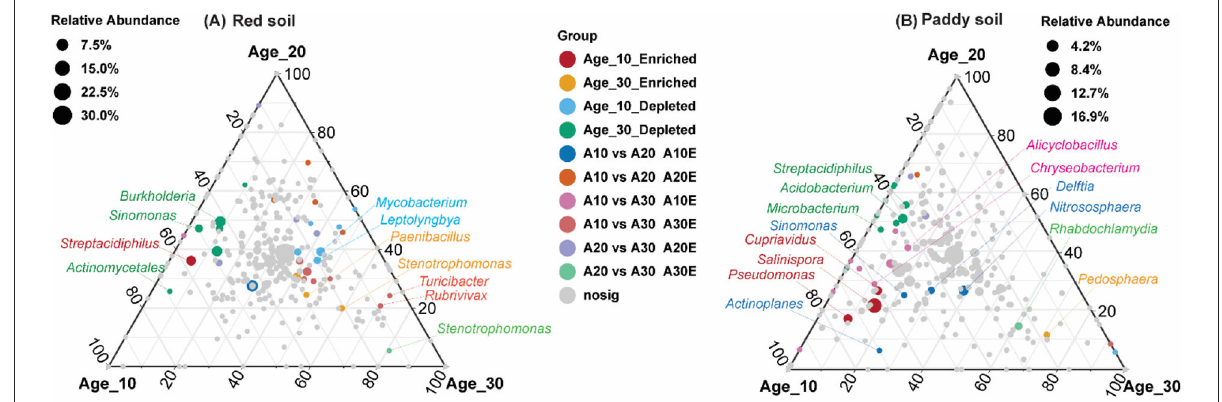
FIGURE7 Ternary plot analysis. Ternary plot represents the soil bacterial communities with significant differences in relative abundance in different tree ages at the genus level in (A) red soil and (B) paddy soil. Here, Age_10, Age_20, and Age_30 denote the different pomelo tree ages of 10, 20, and 30 years, respectively. Each point represents species, and the size of the point corresponds the relative abundance of each species. “Enriched” denotes the significant increase in relative abundance compared with others two, while “depleted” represents the significant lower relative abundance of a group than other two groups, and non-sig represents the non-significant differences among different age